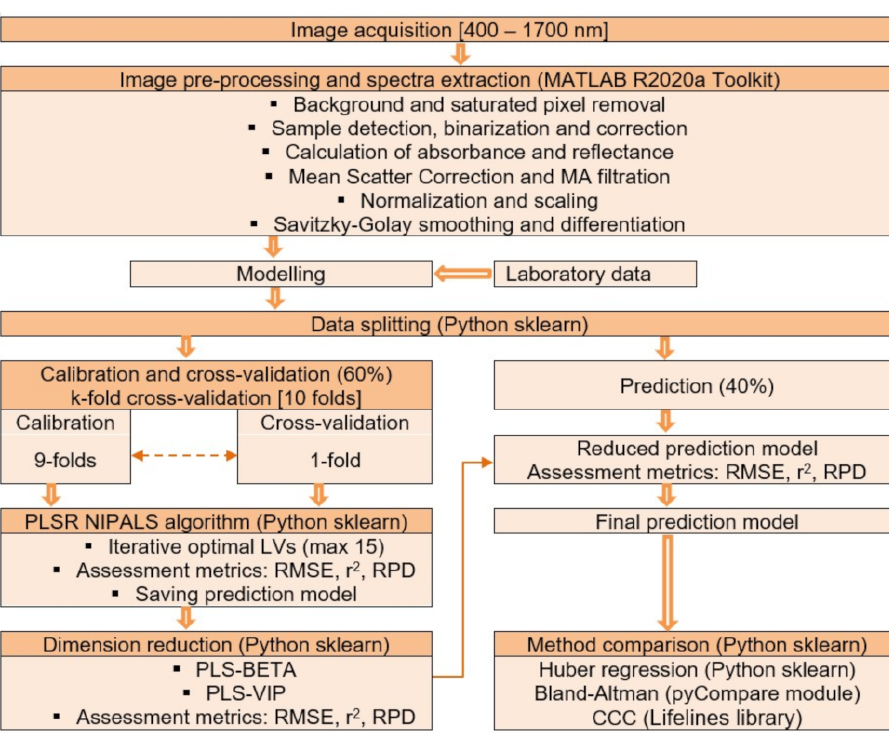
Figure 1. Summary of data acquisition, processing and model